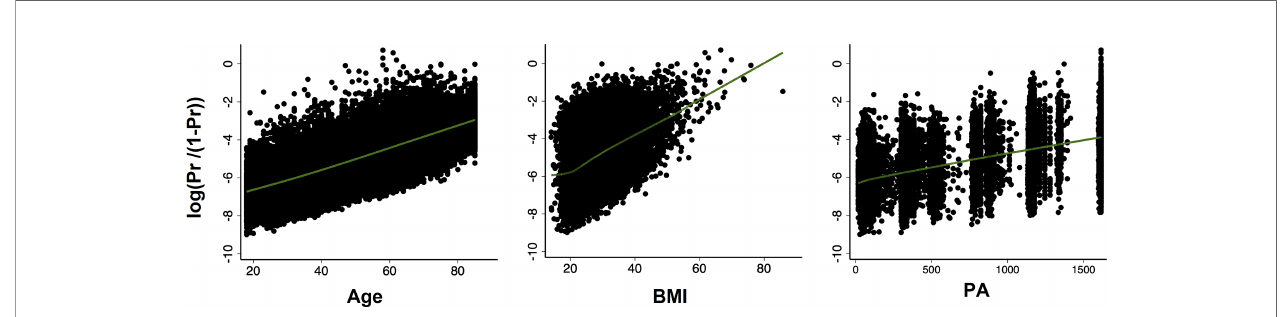
FIGURE 1 | Scatter plots with locally weighted scatter plot smoothing (LOWESS) of the relationship between probability of diabetes (in logit scale) and continuous covariates (age, BMI, PA, respectively). All relationships were